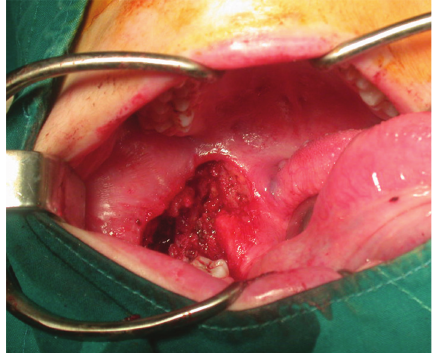
Figure 4: Postoperative appearance of the operative